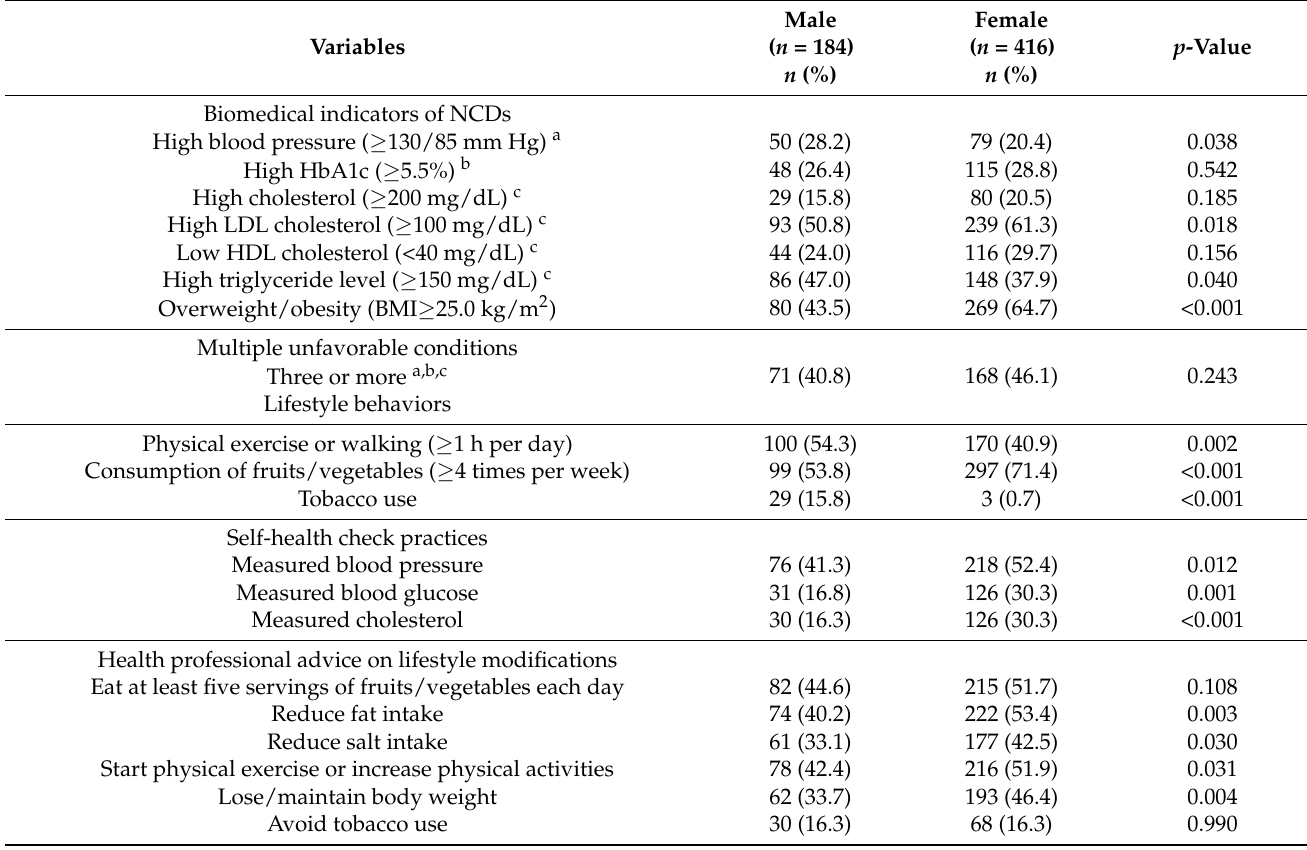
Table 2. Prevalence of biomedical indicators related to non-communicable diseases, comorbidities, lifestyle behaviors, self-health check practices, and receipt of health professional advice by gender among schoolteachers in Afghanistan ( n =